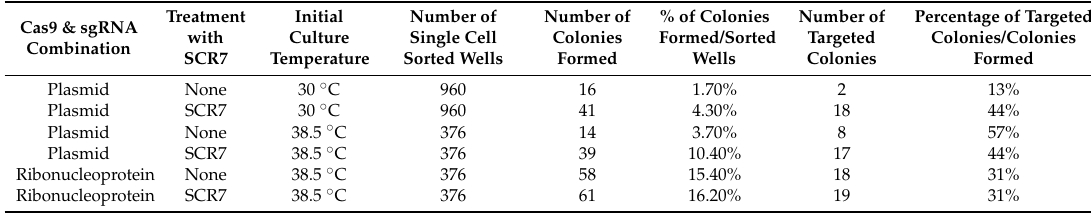
Figure 1. Targeted knockin of two pseudo attP sites (100 bp) downstream of the porcine COL1A locus. ( A – C ) Agarose gel electrophoresis analysis of amplicons generated by primers bordering the COL1A targeting site. PCR amplicons of representative colonies derived from plasmid transfection and transient incubation at 30 °C ( A ) or 38.5 °C ( B ); and ribonucleoprotein ( C ) transfection and culture at 38.5 °C. In each panel, representative colonies showing a new band with predicted shift of 100 bp on the agarose gel produced by successful targeting and introgression of the two pseudo attP sites is marked by a red star. In each panel, the top row represents knockin in the presence of SCR7, the middle row without SCR7 and the bottom row represents Sanger sequencing of the amplicon. Multiple sequence alignment of wild type (WT) COL1A gene and two pseudo attP knockin sites are shown. Each nucleotide is color coded. Table 1. Summary of CRISPR/Cas knockin experiments.